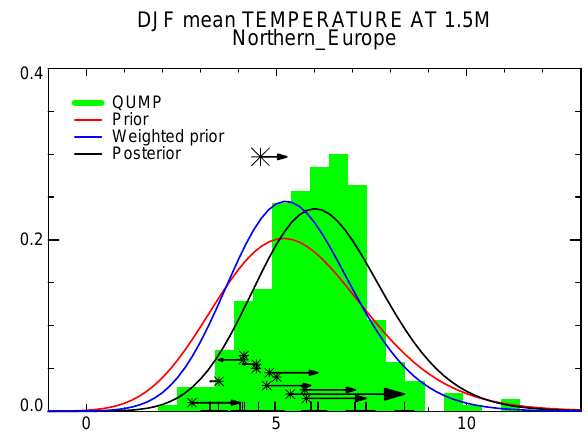
Fig. 2. Equilibrium probability distributions functions for winter surface temperature change for the Giorgi-Francisco (2000) North- ern Europe region, following a doubling of CO 2 concentrations. The green histogram (labelled QUMP) corresponds to the 280 equi- librium HadSM3 simulations used to construct a statistical emula- tor for this response. The red curve (labelled prior) is obtained from a large sample of emulated responses and is the prior distribution for this climate variable. The blue curve (labelled weighted prior) shows the effect of applying observational constraints to the prior distribution. The asterisks show the positions of our best emulated values of the 12 CMIP3 multi-model members and the arrows quan- tify the discrepancy between these best emulations and the actual multi-model responses. These discrepancies have a broadening ef- fect on the PDFs, and can shift the mean of the posterior distribution (black curve) relative to the weighted